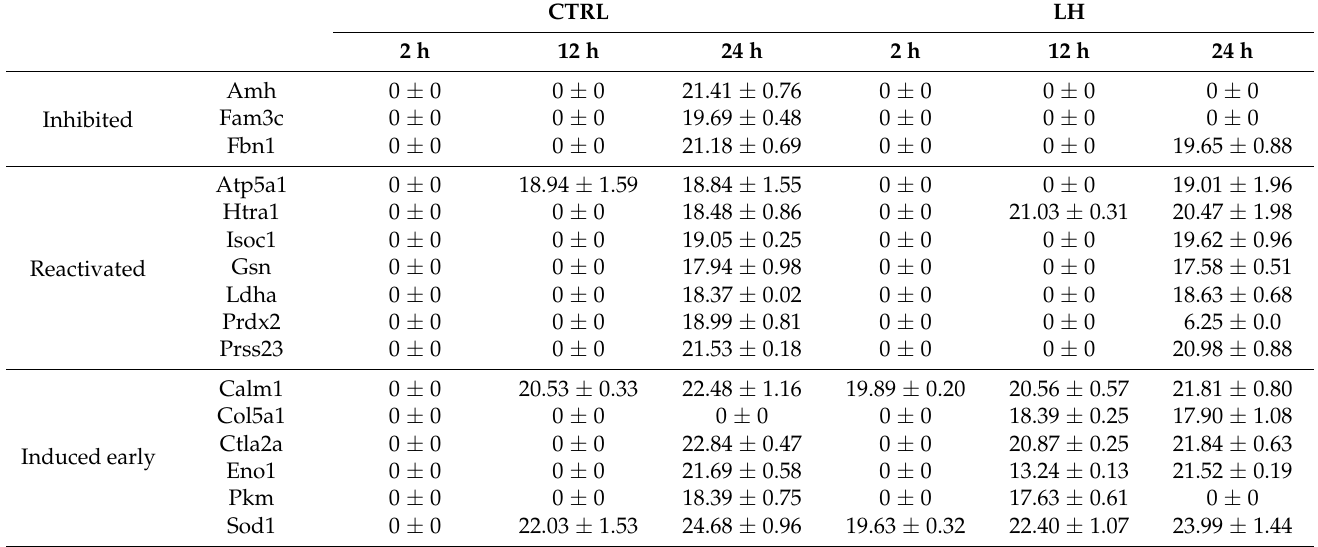
Table 1. Expression in CTRL and LH groups of metabolites hypothetically implicated in the protective effect of LH against CIS-induced apoptosis. Mean log 2 iBAQ values and SD are reported. LH was able to inhibit the expression and/or the release in the microenvironment of probable proapoptotic factors induced by CIS in the ovarian tissues (Inhibited); reactivate those of several antiapoptotic factors inhibited by CIS (Reactivated); anticipate the induction of other (Induced early). CTRL LH 2 h 12 h